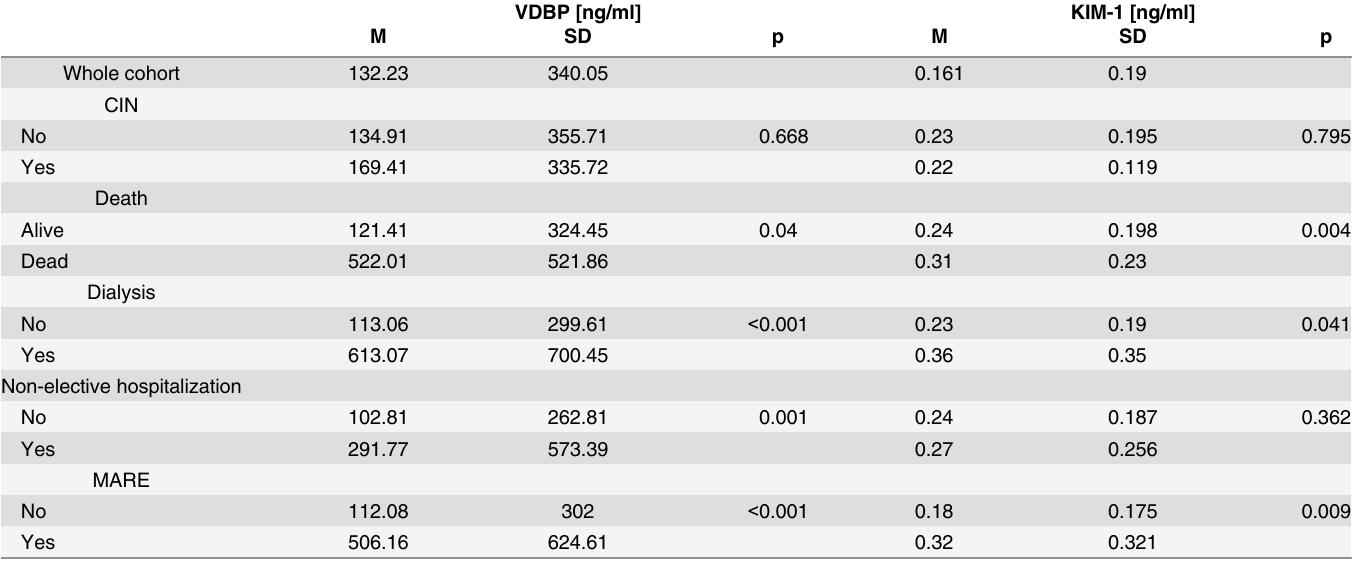
Table 3. Urinary concentration of VDBP and KIM-1 24 hrs after CM injection comparison in patients with and without complications. VDBP: vitamin D binding protein, KIM-1: kidney injury molecule 1, CIN: contrast induced nephropathy, MARE: major adverse renal event, GFR: glomerulary filtration rate estimated with the MDRD formula, N: number of patients, M: mean, SD: standard deviation, p: significance according to MANOVA, p < 0.05 – is statistically